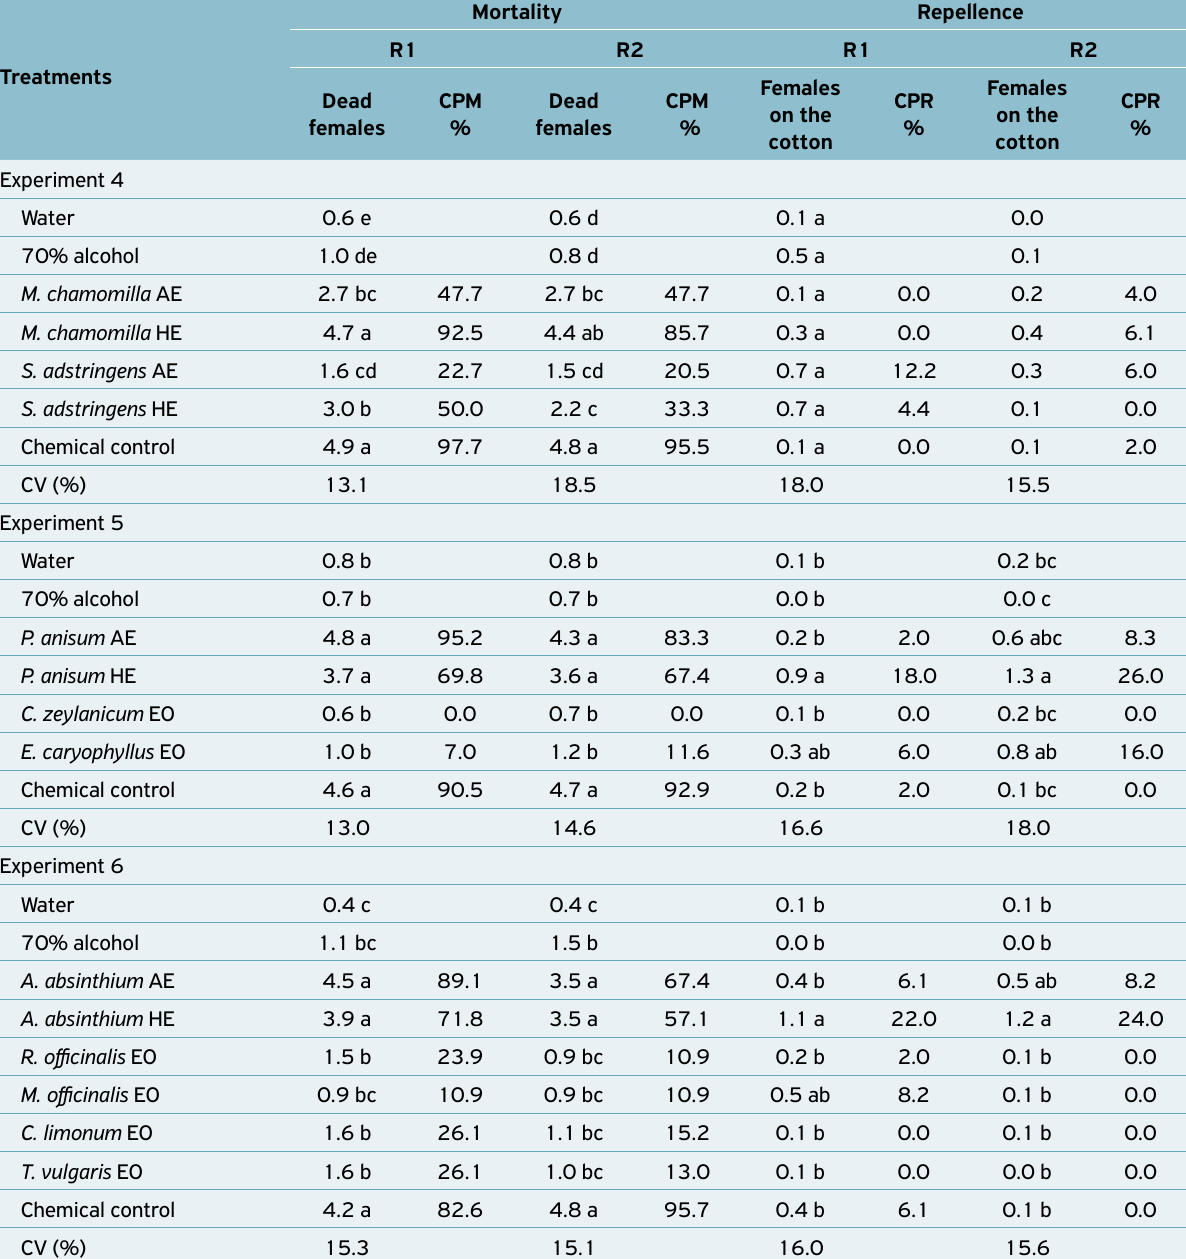
Table 3. Average number of Tetranychus urticae females dead and found on the cotton, corrected percentage mortality and corrected percentage repellency, 120 hours after spraying with plant extracts. Experiments 4 to 6, two replicates (R1; R2). Ilha Solteira, São Paulo,